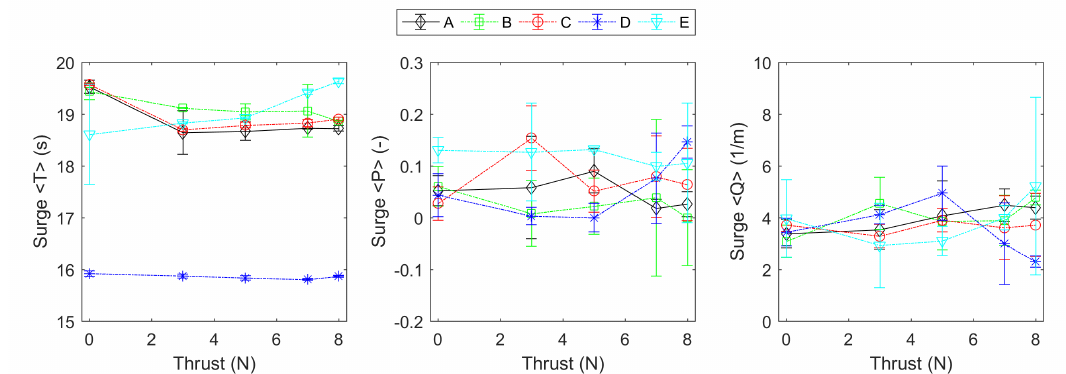
Figure 9. Effect of thrust on surge natural periods ( left ), linear ( middle ) and quadratic damping estimates ( right ).